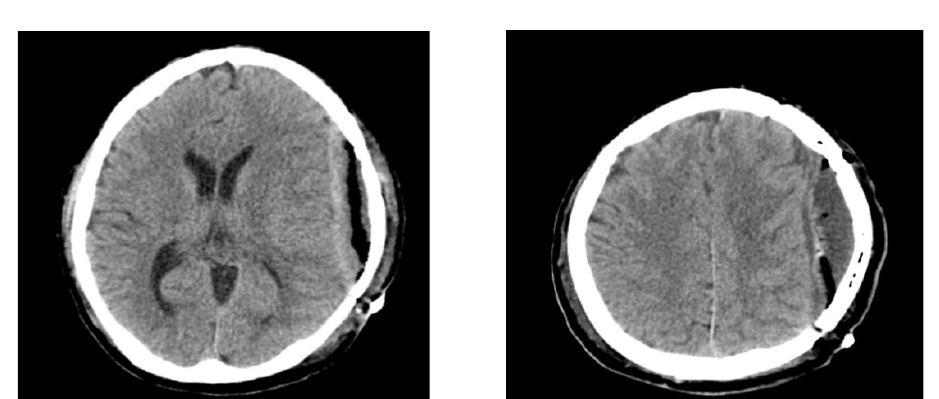
Figure 1. Brain computed tomography scans at 3 months after cranioplasty demonstrate air bubbles and epidural fluid collection. Although cranioplasty is a relatively simple procedure, it carries a